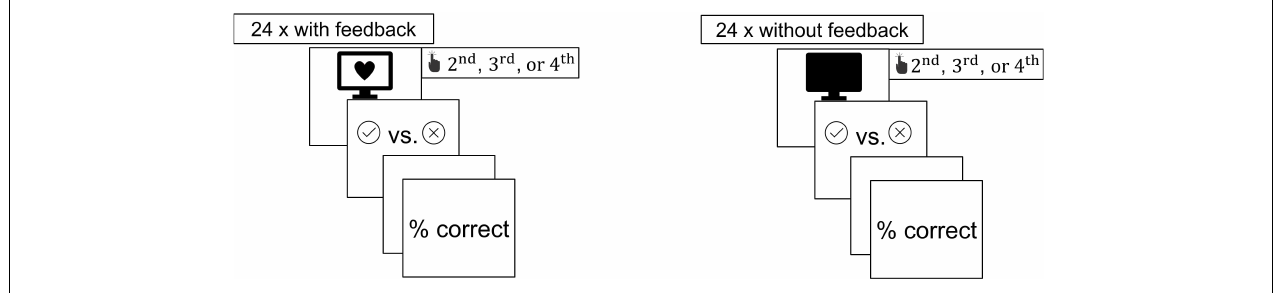
FIGURE 1 | Procedure of the heartbeat perception training paradigm.